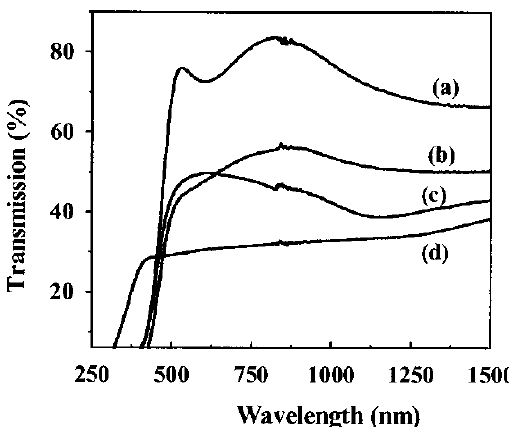
FIGURE 11 Transmission spectra of spin coated V 2 O 5 thin films treated at various applied potentials: (a) as-deposited, (b) þ 1200mV, (c) þ 200mV and (d) (cid:3)